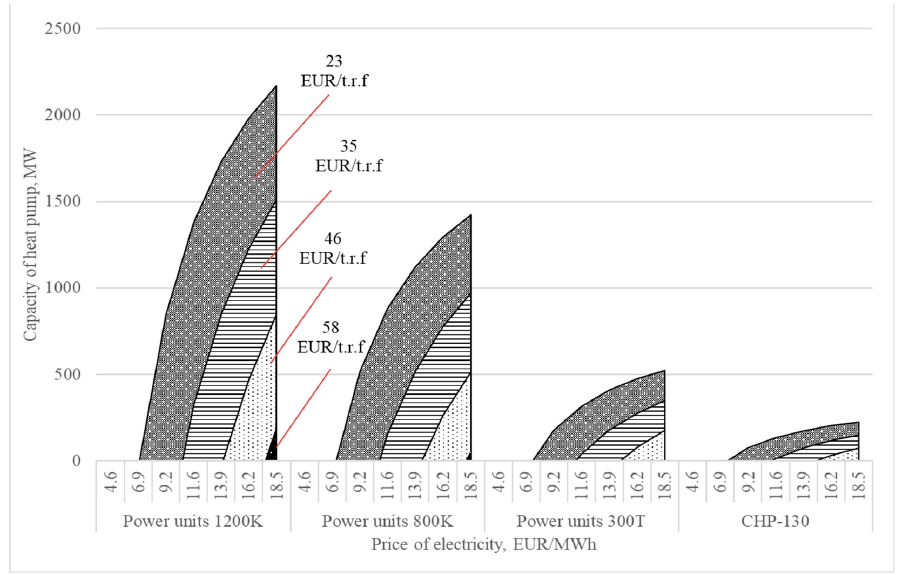
Figure 6. The range of permissible HP capacity for TPPs with the same level of efficiency. The Russian electric power market is characterized by a significant territorial une- venness of prices due to the different TPPs performance located in different regions and the limited capacity of transmission lines. Thus, TPPs of the same capacity and efficiency in different power systems will correspond to varying maximum HP capacities and ac- ceptable fuel prices. For example, Figure 3 shows the range of HP power capacity for the CPSs of the Russian Federation for TPPs with a capacity of 200 MW with a SRFC value of 310–320 g.r.f/kWh. Figure 7 shows that the use of HP at a TPP located in the CPS of Siberia (the average price of electricity is 10.3 EUR/MWh [43]) becomes inefficient (from the point of view of working in the electric power market) when the fuel price is above 35 EUR/t.r.f. For a similar CHP in the UES of the south (the average price of electricity is 17.7 EUR/MWh [43]), the ceiling fuel price is 59.5 EUR/t.r.f.